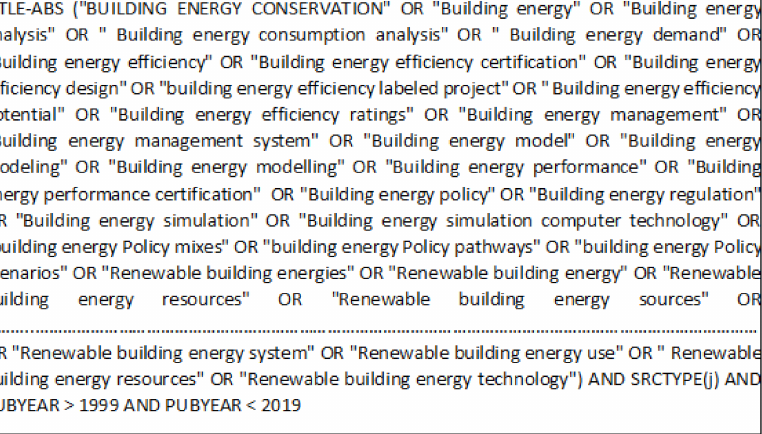
Figure 3. Fragment of the query applied in the search on SCOPUS database (source: